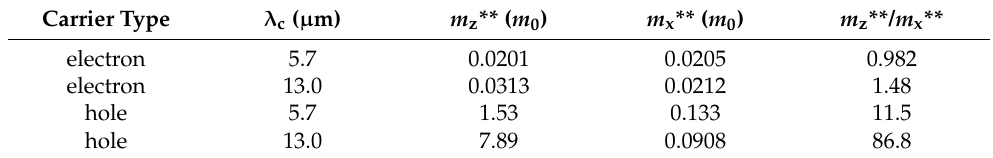
Table 1. Conductivity effective masses for an MWIR and a VLWIR (4 n , n )-InAs/InAs 0.5 Sb 0.5 T2SLS. Carrier